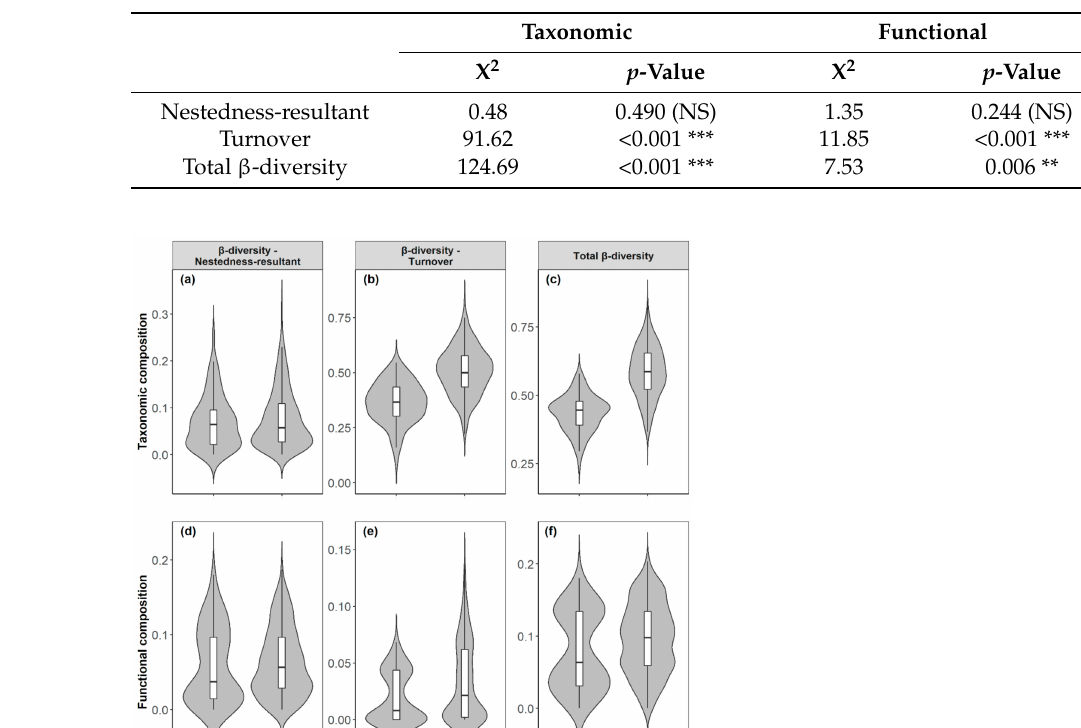
Table 3. Kruskal–Wallis statistical outputs indicating the effects of restoration on different β -diversity